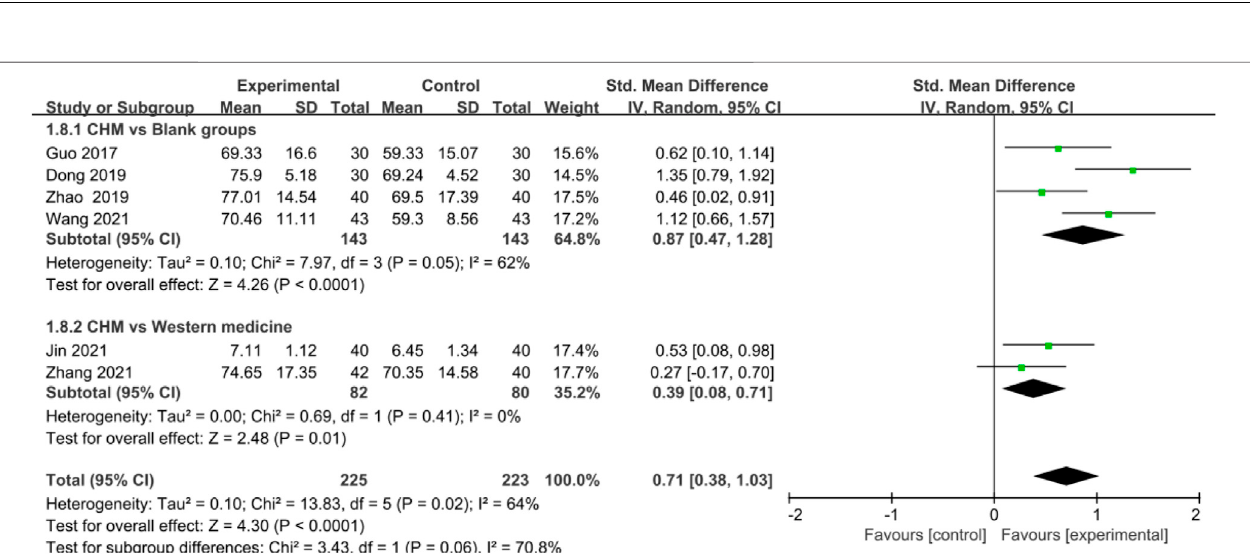
Frontiers in Pharmacology |